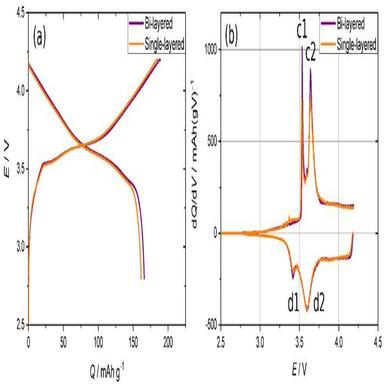
Formation cycle of the FCCs consisting of single- (orange) and bi-layered (purple) negative electrodes. (a) Chronovoltammogram and (b) DVA representation.